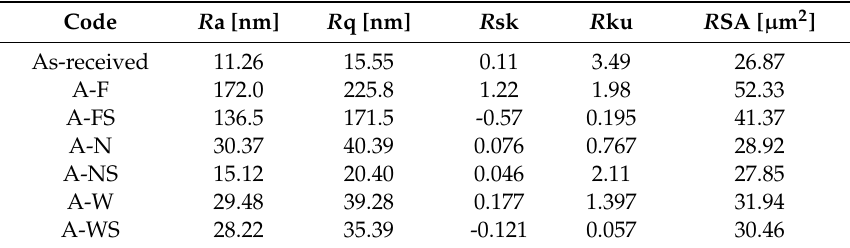
Table 3. Roughness parameters determined by AFM image analysis.